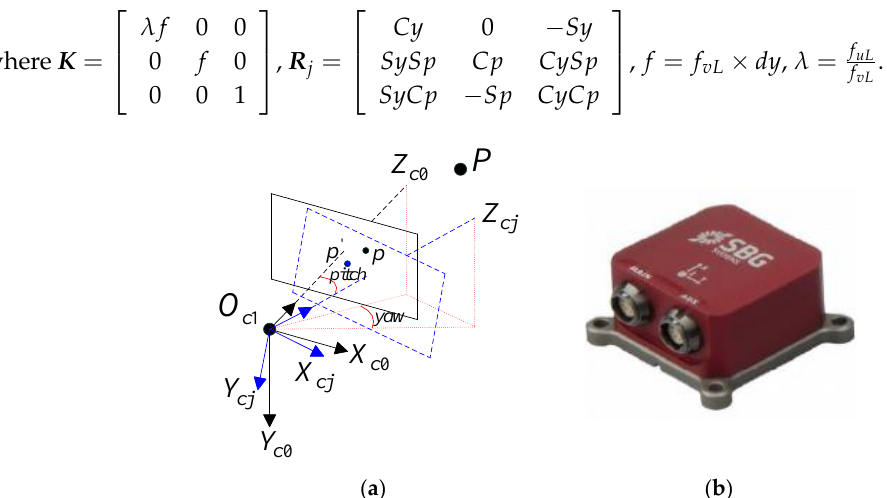
Figure 2. Dynamic mathematical model of the left camera and angle measuring instrument: ( a ) Rotation model of the left camera; ( b ) SBG angle measuring instrument.